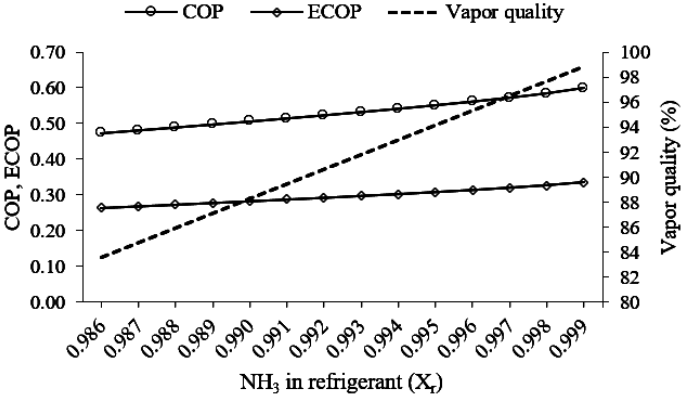
Figure 17. Effect of X r on COP, ECOP and vapor quality at evaporator exit.